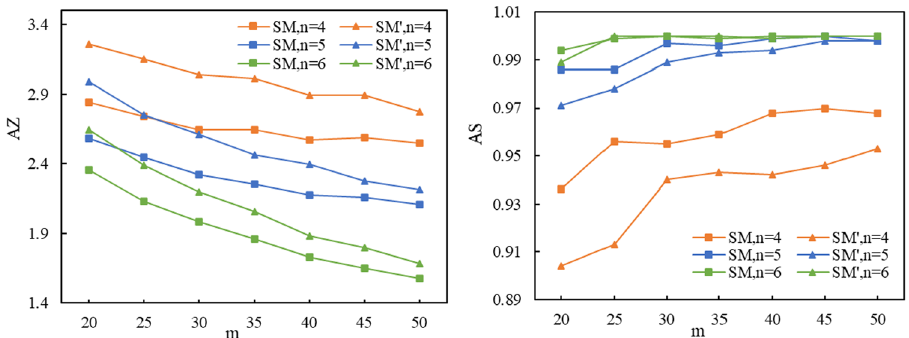
Fig. 2 AZ and AS under differ- ent parameters m and